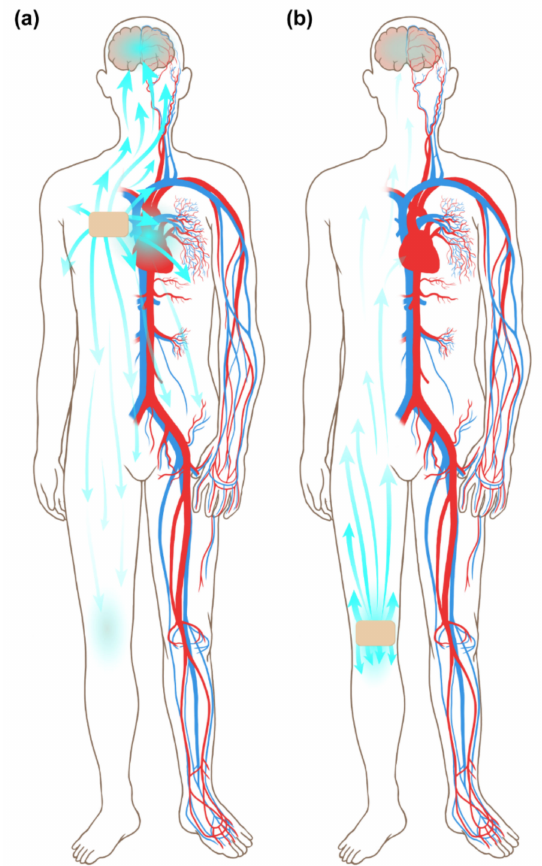
Figure 2. ( a ) Application of the buprenorphine transdermal patch on the chest of knee osteoarthritis patients (conventional application method), ( b ) application of the buprenorphine transdermal patch on the painful knee joint of knee osteoarthritis